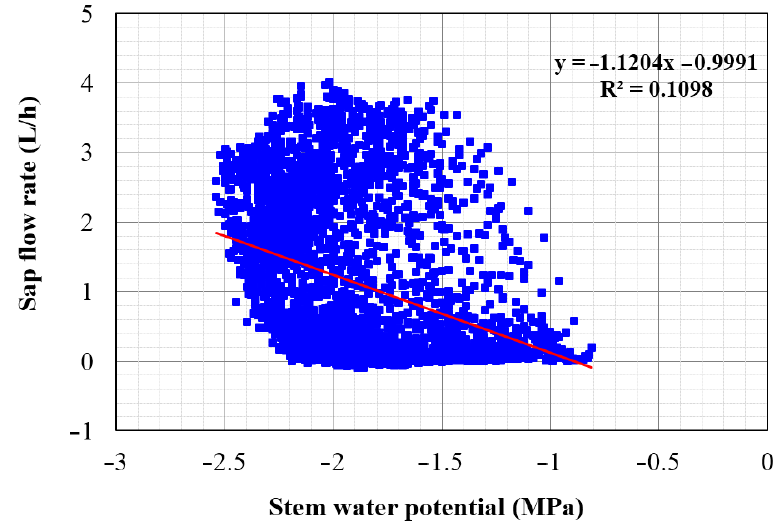
Figure 13. Correlation between sap flow rate and stem water potential in L. confertus .